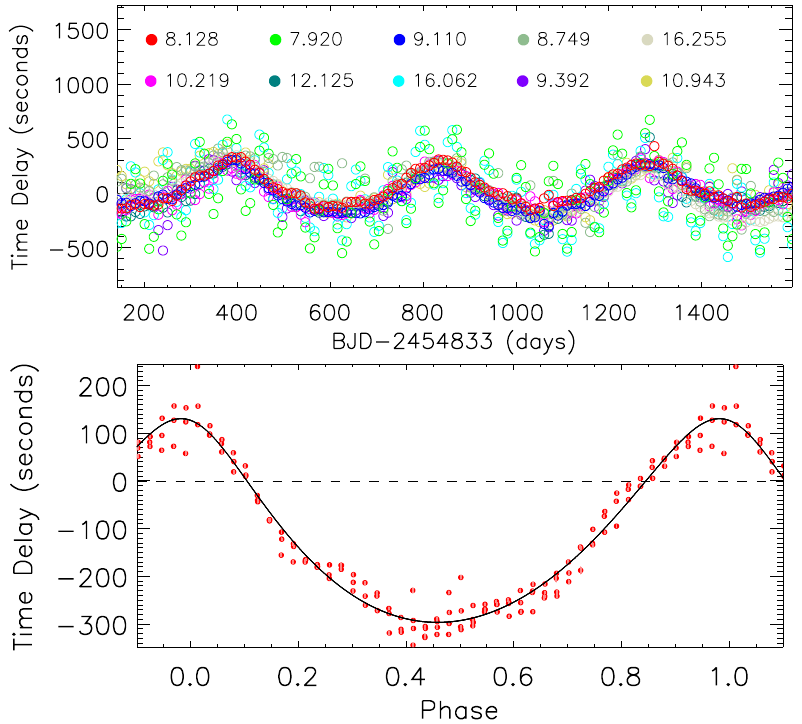
Figure 7. Similar with Figure 3 but for KIC